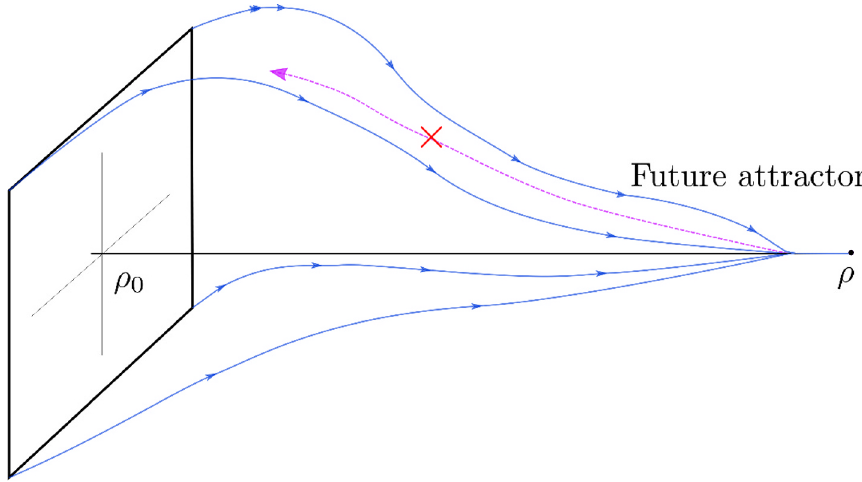
Figure 1. Phase portrait of some nonautonomous system. At the point (cid:26) 0 the equilibrium state in the future has not been formed yet. If we wait in(cid:12)nitely long enough, this state will start to form at (cid:26) . As this is happening, the (cid:13)ow lines at late times become further dense around the equilibrium point. This dense set is the future (forward) attractor. Notice that there is no attraction in the past of (cid:26) due to the non-existence of an equilibrium state ((cid:12)xed point), a statement that does hold in autonomous systems | cf. RG (cid:13)ow space of (cid:12)eld theories. at (cid:28) ! 1 that the system reaches a (cid:12)xed point X (cid:3) ( (cid:28) ) and an equilibrium (cid:3) (cid:3)